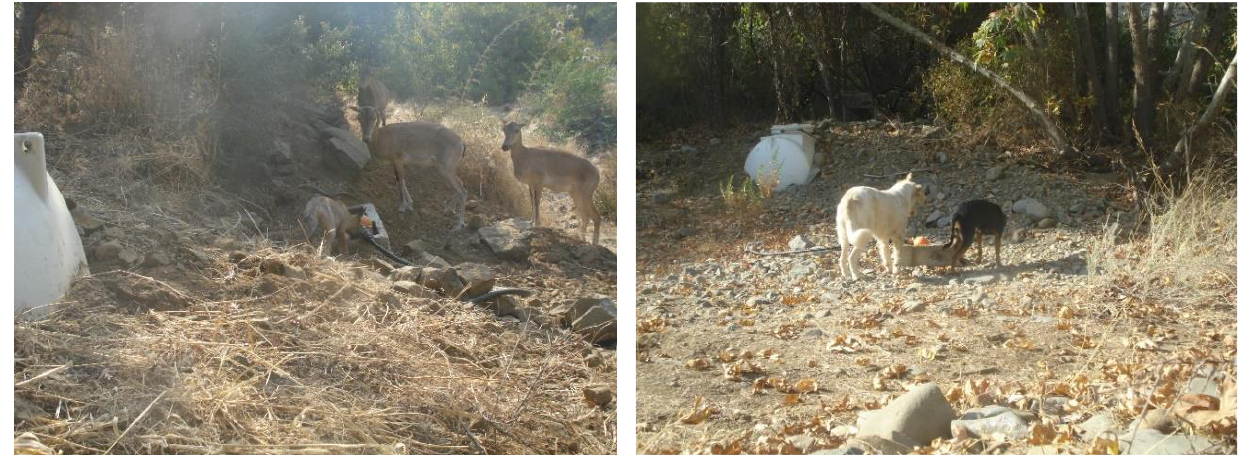
Figure A3. The water troughs are used by other wildlife for watering (e.g., red fox, left; feral dogs; right) (photos: © Game and Fauna Service, Ministry of Interior, Cyprus).